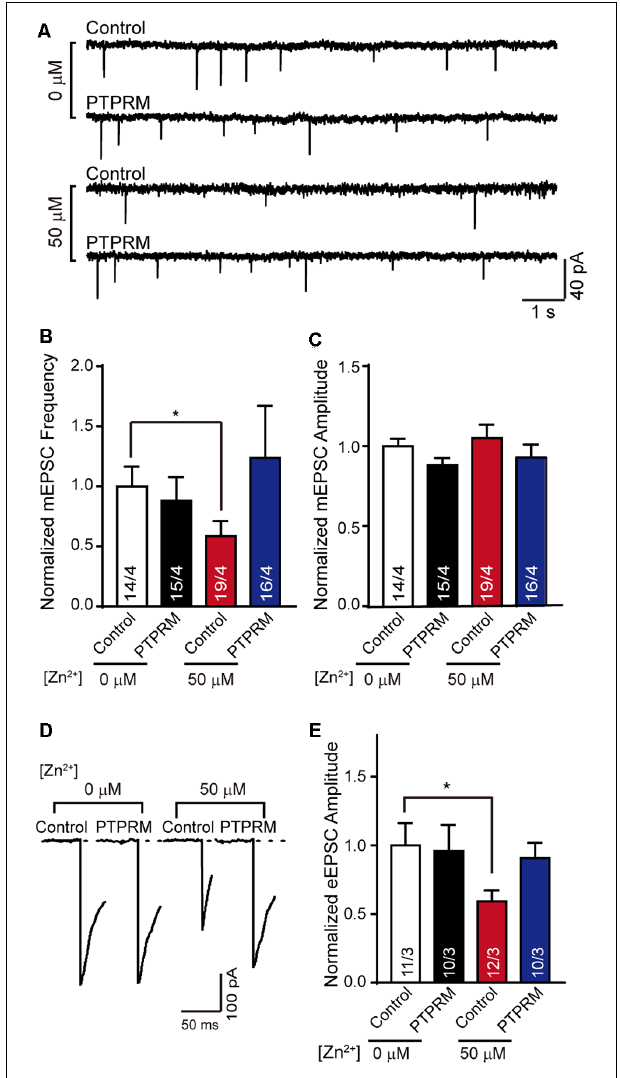
FIGURE 5 | PTPRM is key for excitatory synaptic signal transduction mediated by Zn 2+ . (A) Representative traces of mEPSCs recorded in cortical neurons overexpressed PTPRM or not cultured with/without 50 µ M Zn 2+ when expressed PTPRM or not. (B) Summary graphs of the normalized frequency of mEPSCs for all conditions as described in panel (A) . (C) Statistical summary of the normalized amplitude of mEPSCs for all conditions as described in panel (A) . (D) Representative of eEPSCs recorded from cortical neurons described in panel (A) . (E) Statistical summary of normalized amplitude of eEPSCs recorded in the neurons described in panel (A) . Data information: numbers of cells/independent cultures analyzed are listed in the bars. Data shown in summary graphs are mean values ± SEM. Statistical significance was analyzed by Student’s t -test. * p <